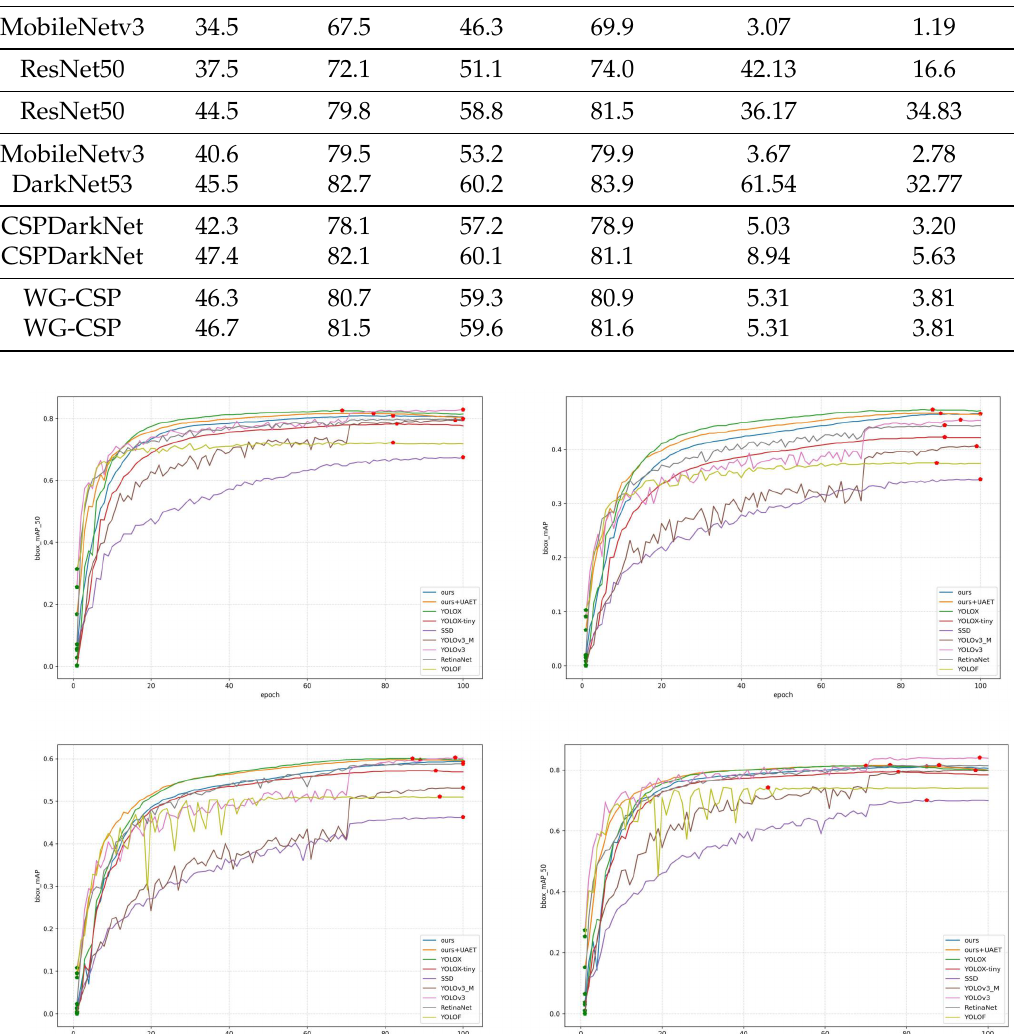
Figure 8. The average precision curves of the underwater